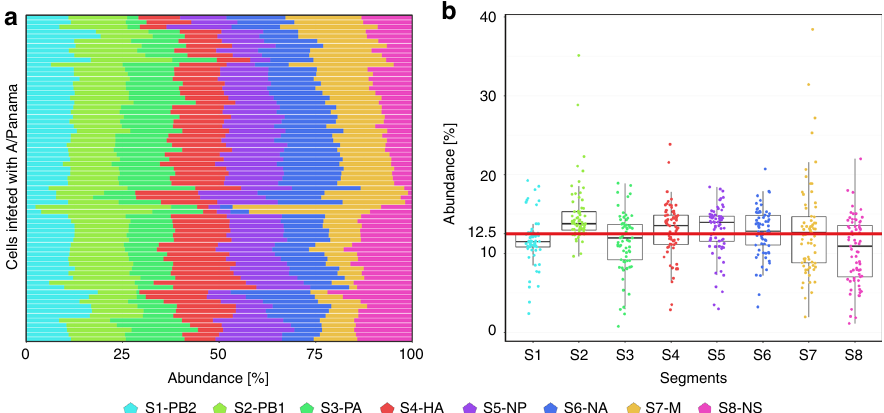
Fig. 2 Viral RNA (vRNA) abundances in A/Panama-infected A549 cells 10 h.p.i. a Relative abundances of all vRNA segments per cell as measured by fl uorescence in situ hybridisation (FISH). For each of the measured cells ( n = 69 from four independent experiments), the number of spots that were detected was counted and normalised to the total number of spots per cell. The colouring scheme is the same as in Fig. 1. b Data shown in a in a Tukey boxplot representation. Upper bound of box, centre and lower bound of the box represent the 75th percentile, the 50th percentile (median) and the 25th percentile, respectively. Upper and lower whiskers represent the maxima and minima of the boxplots showing the respective largest or smallest value within 1.5× interquartile range above the 75th or below the 25th percentile (bounds of box). In all, 12.5% (red line) corresponds to the expected fraction for each vRNA in a uniform distribution. For the segments, there is no signi fi cant difference (ANOVA, F test, one-sided, α = 0.05) between the cells ( P > 0.999). The application of ANOVA requires Gaussian distribution (ful fi lled, see Supplementary Fig. 7) and the same variability (standard deviation) for the segments. However, the Bartlett test (one-sided, α = 0.05) shows that the variability of the individual segments is signi fi cantly different ( P > 0.0001). The Kruskal – Wallis test does not presuppose homogeneity of variability, but agrees with the F test in the result, i.e., no signi fi cant differences (one-sided, P > 0.999). Source data are provided as a Source Data fi